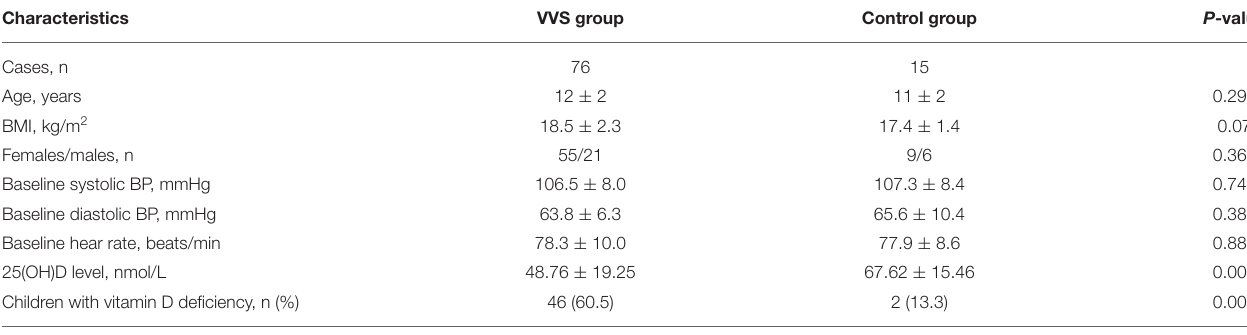
TABLE 1 | Demographic and clinical characteristics of patients and control subjects.